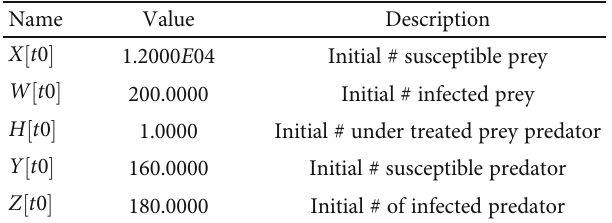
Table 5: Initial conditions used for model